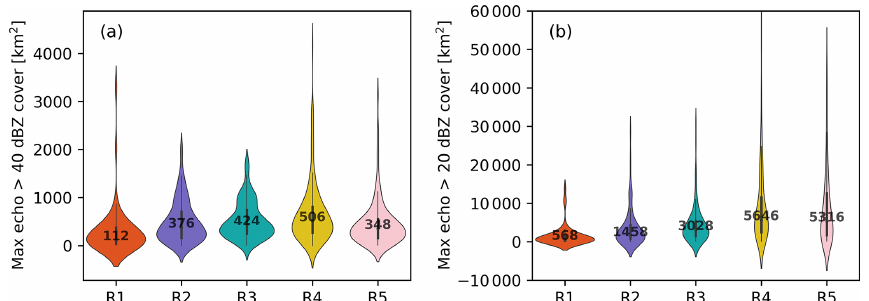
Figure 12. As in Fig. 4, the maximum contiguous 2km Constant Altitude Plan Position Indicator (CAPPI) radar echo coverage (km 2 ) for any radar scan within a regime day that is occupied by radar echoes exceeding an intensity of (a) Z > 40dBZ or (b) Z > 20dBZ for the hours between 12:00 and 00:00UTC of that day.